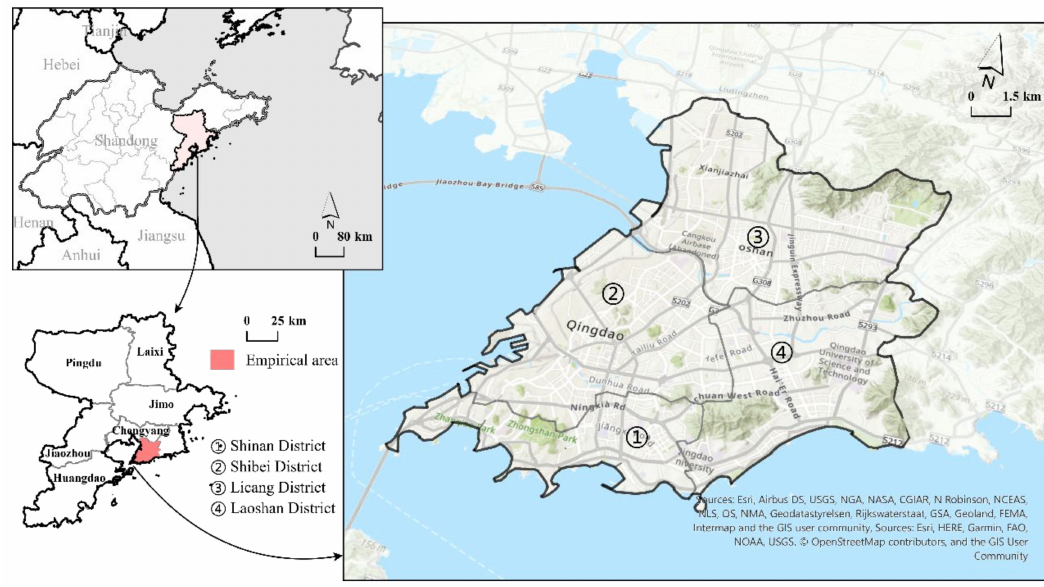
Figure 1. The geographical location of the empirical